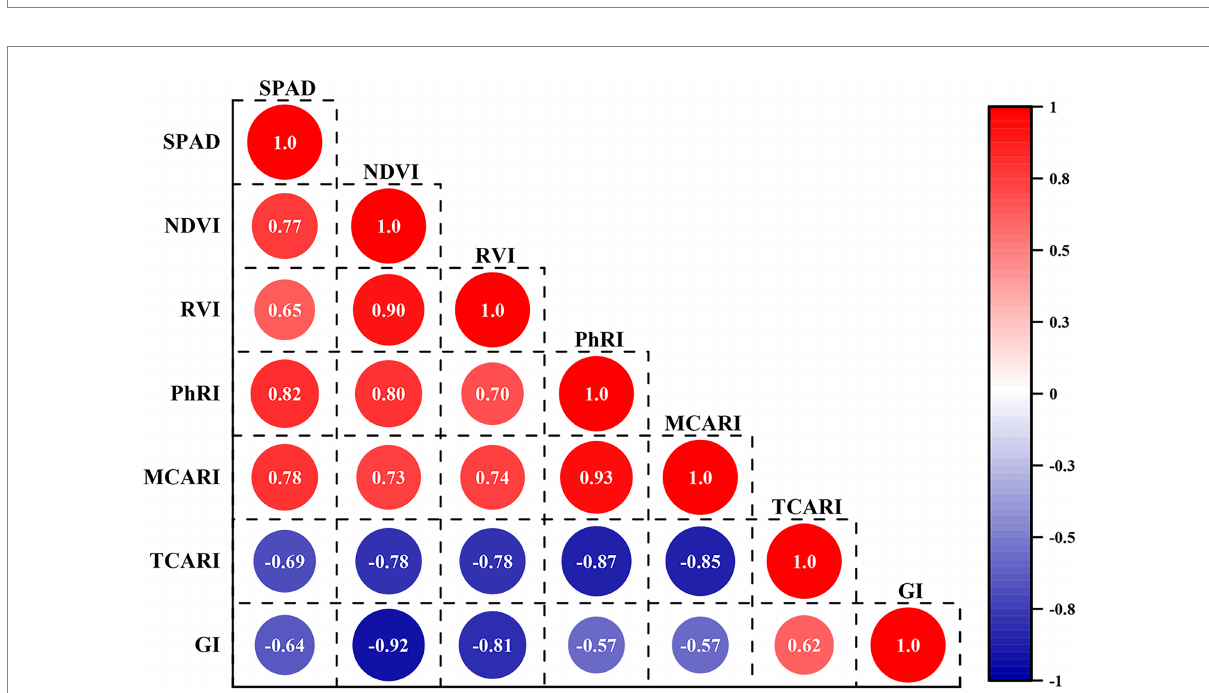
FIGURE 4 Spectral curves of jujube trees for different leaf mite damage indices.